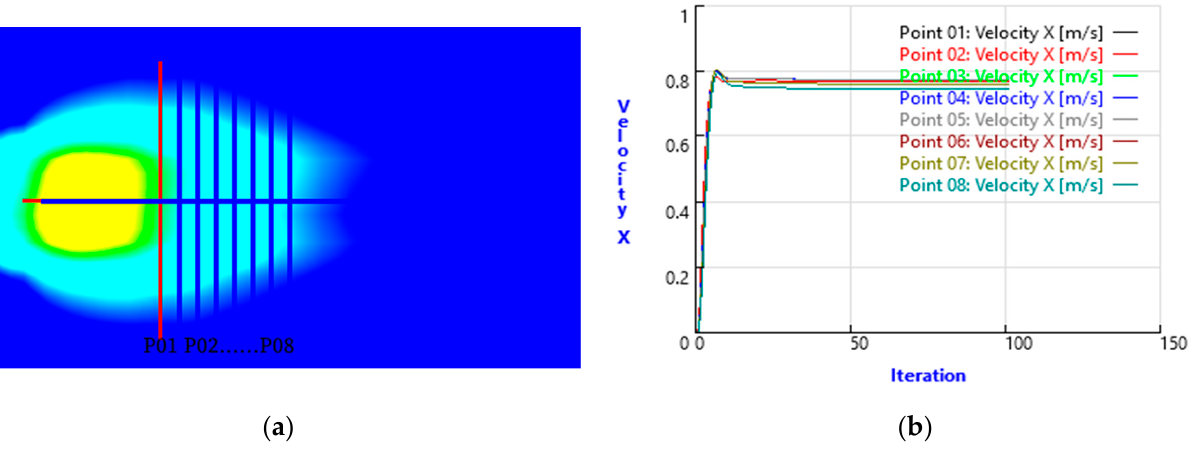
Figure 4. Monitoring point distribution map and x -direction speed curve: ( a ) monitoring point settings; ( b ) speed in x -direction at each point.